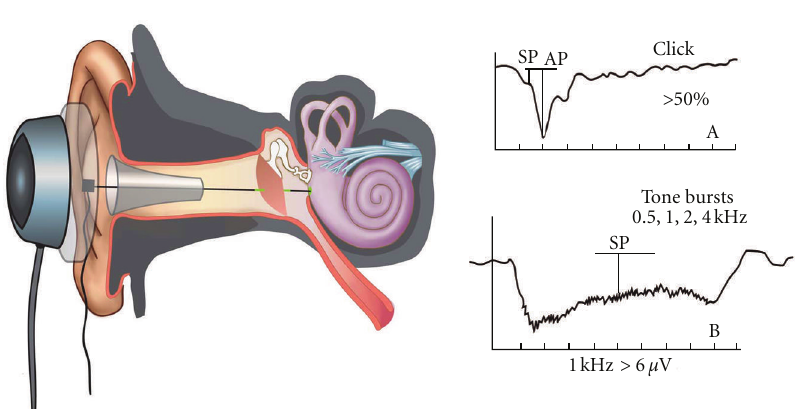
Figure 2: A schematic illustration of the placement of the transtympanic needle electrode and the electrocochleographic waveforms.